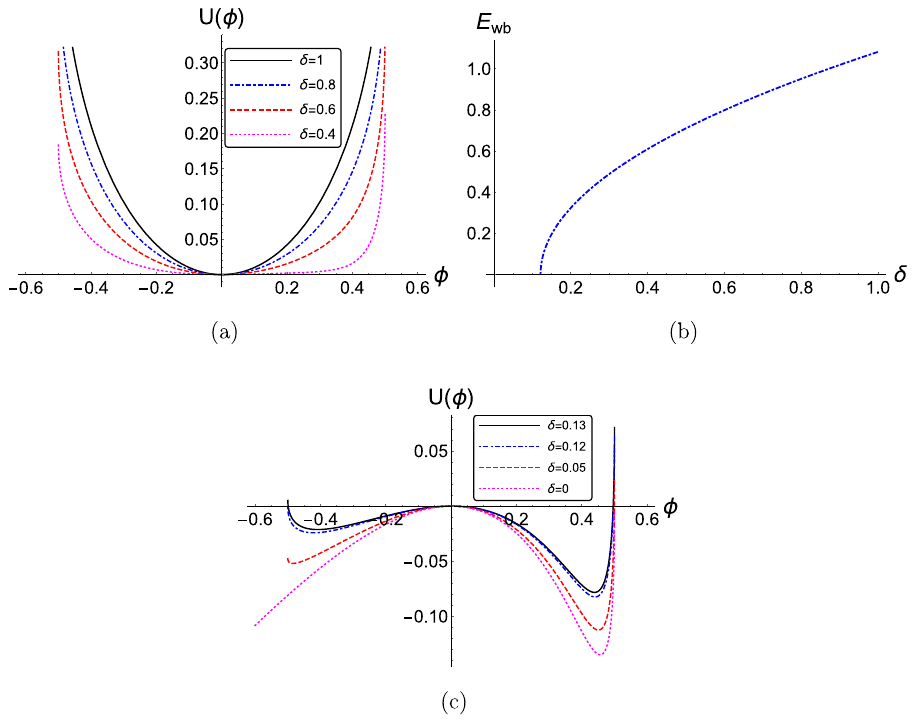
Figure 2. (Color online) ( a ) The effect of the variation of the negative-to-positive ion density ratio δ on the pseudopotential U (φ) is depicted, versus the electrostatic potential φ . ( b ) The variation of the minimum normalized wave-breaking electric field amplitude E wb versus the negative ion density ratio δ . ( c ) The pseudopotential U (φ) is depicted for different values of δ near the cutoff point. The parameter values are: κ = 2.5 , µ = 1 , Q = 1 and M = 1 . The numerical values adopted here, as imposed by the maximum allowed value(s) of U (φ) , i.e. U max = I , are presented in Table II (see Online Appendix A).